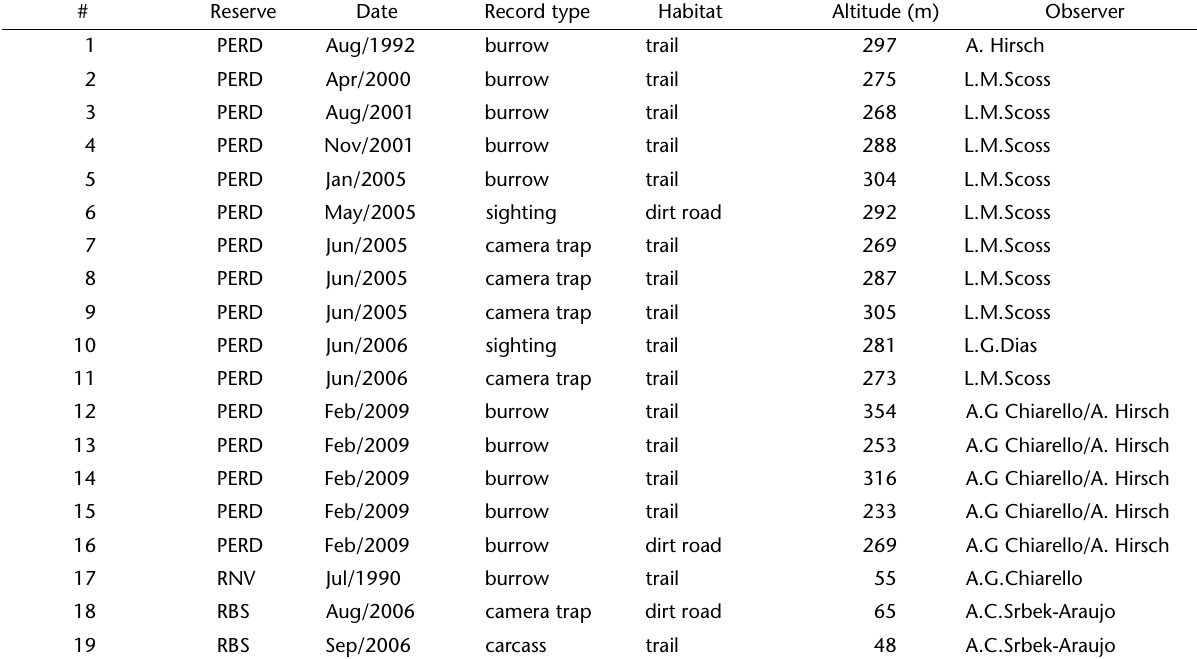
Table I. Records of P. maximus in Atlantic forest reserves of Minas Gerais (PERD) and Espírito Santo (RNV and RBS). Record locations (#) as in figure 1. (PERD) Parque Estadual do Rio Doce, (RNV) Reserva Natural Vale, (RBS) Reserva Biológica de Sooretama.